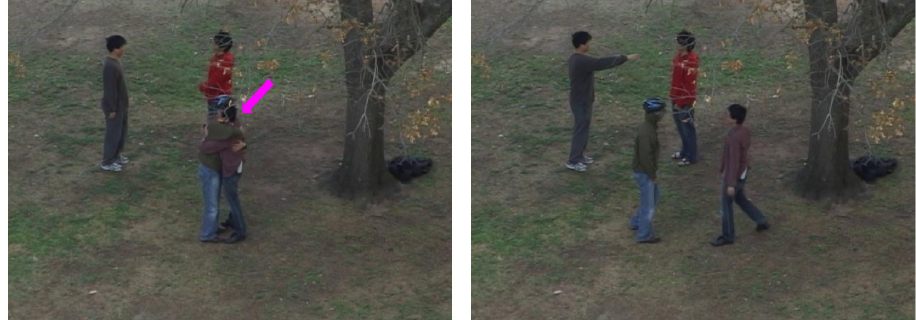
Figure 15. Failure case 2 threat level interpretations. System output for threat—Increases, Human expert opinion on threat—Decreases.